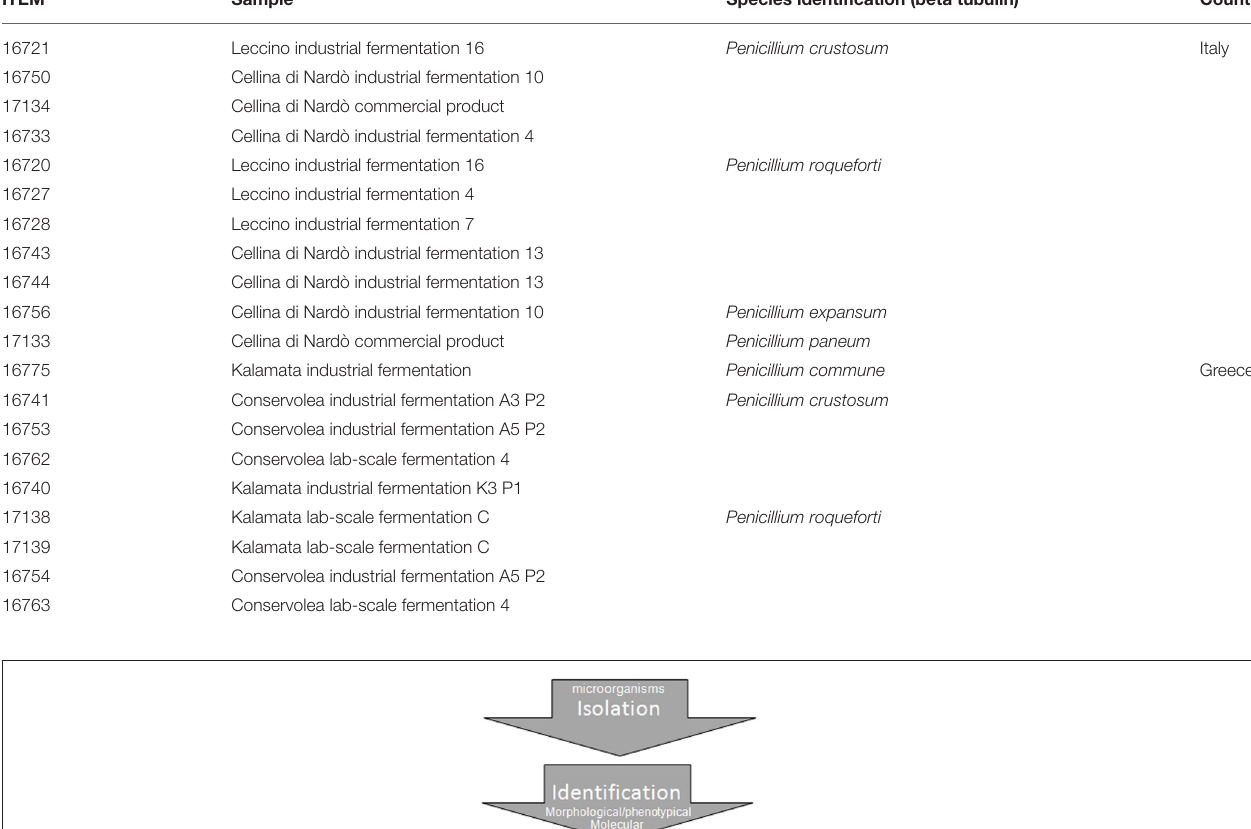
TABLE 1 | Fungal isolates selected for biochemical characterization.